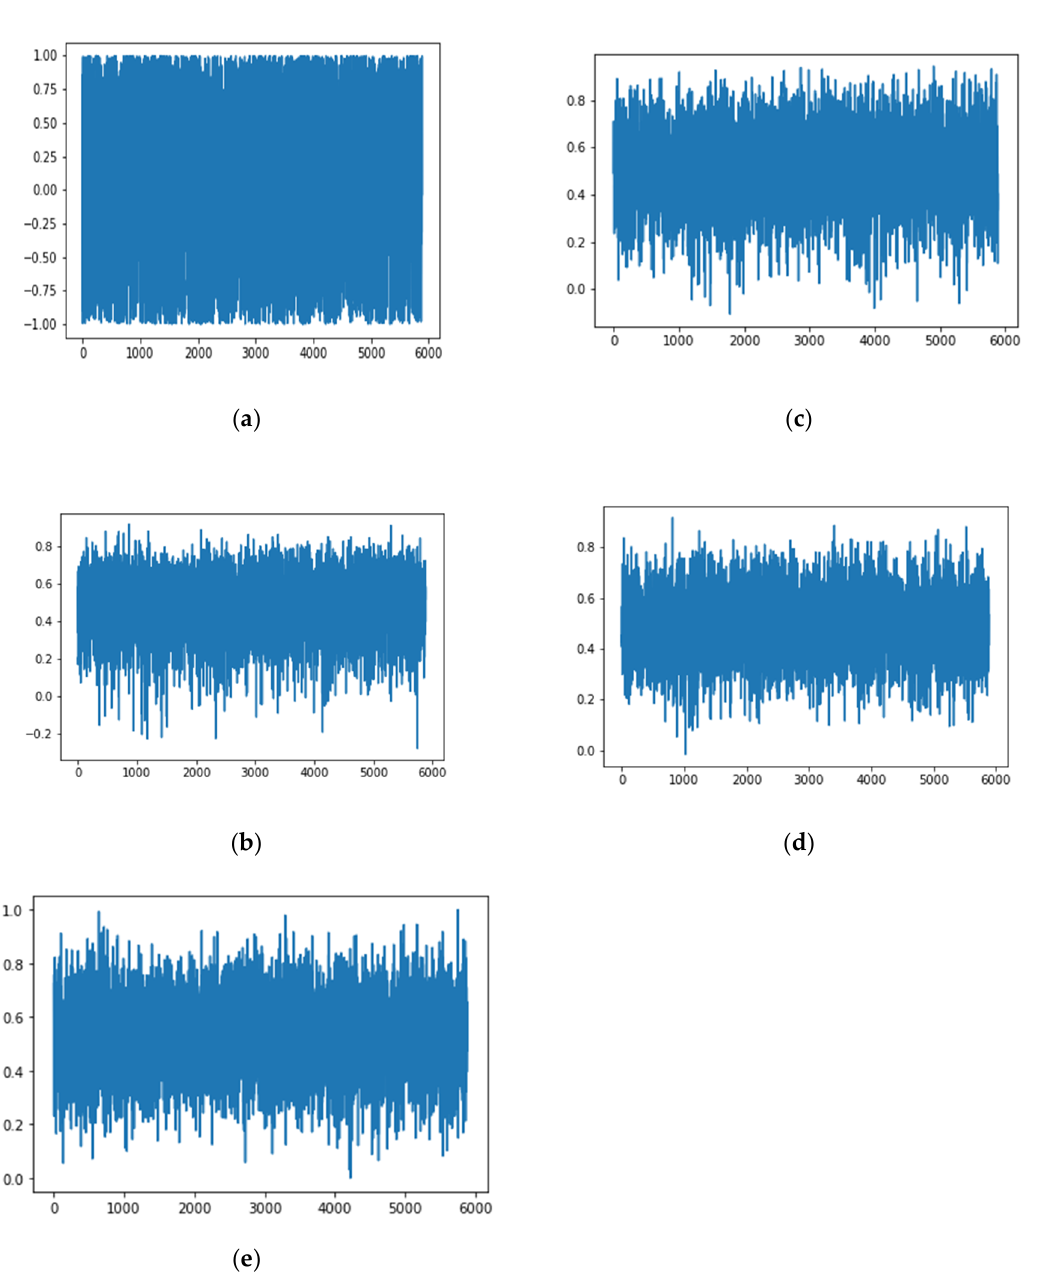
Figure 5. With different training epoch, the changes of the Call behavior signal generated by generator. ( a ) When epoch is 200; ( b ) when epoch is 1000; ( c ) when epoch is 2000; ( d ) when epoch is 20,000; ( e ) a real Call behavior signal.